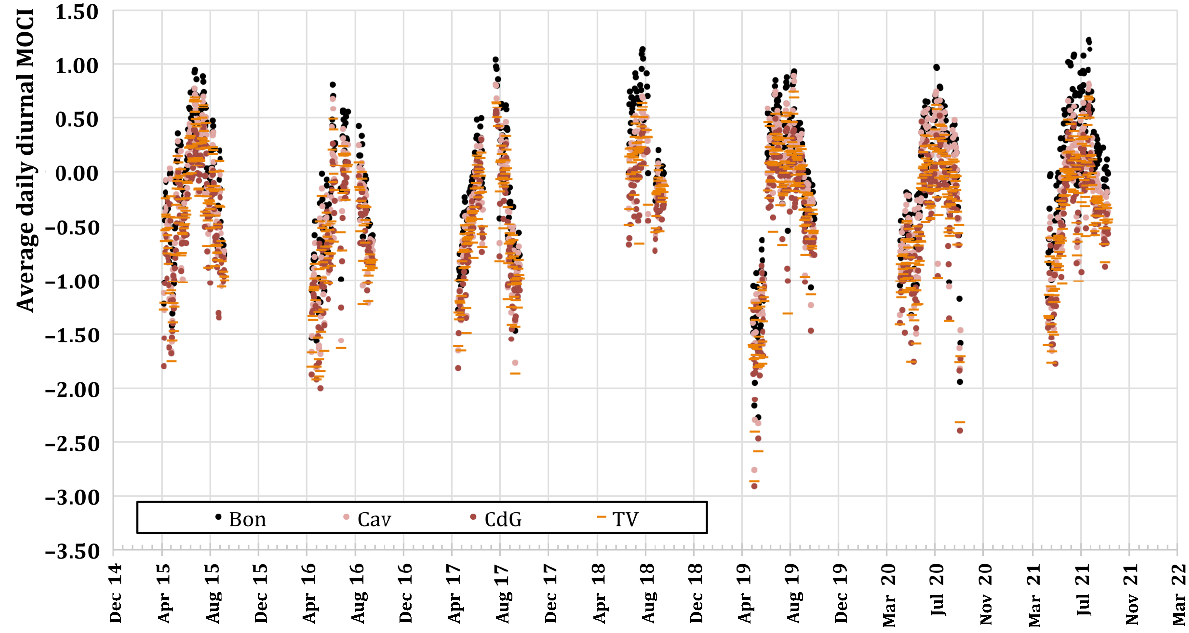
Figure 2. Time series of daily-averaged diurnal (from 06:00 to 19:00 LT) MOCI index for the four ARPA stations.